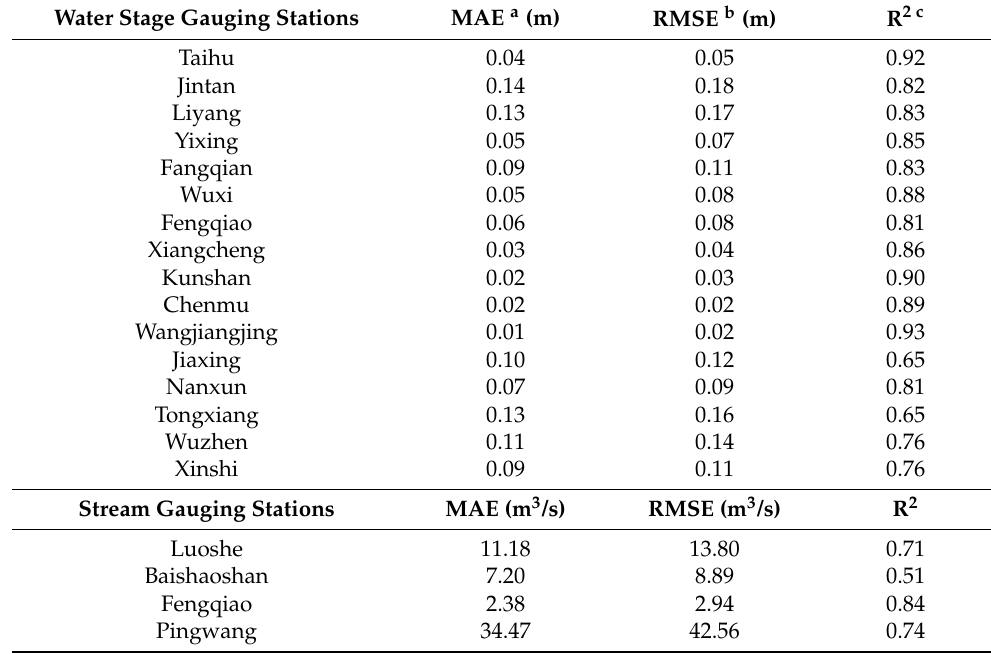
Table 5. Statistical error parameters of simulated and observed water surface elevation (m) and discharge (m 3 /s) in 2000 for Taihu Lake and typical